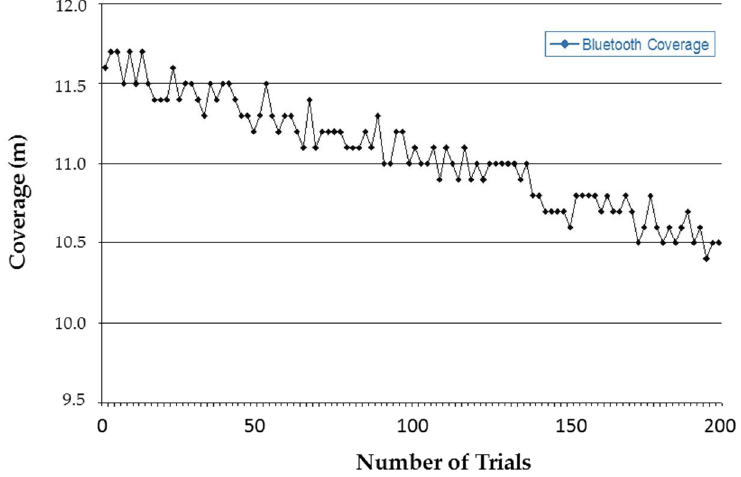
Figure 7. The distance that the module communicates with mobile devices (coverage) for each trial.